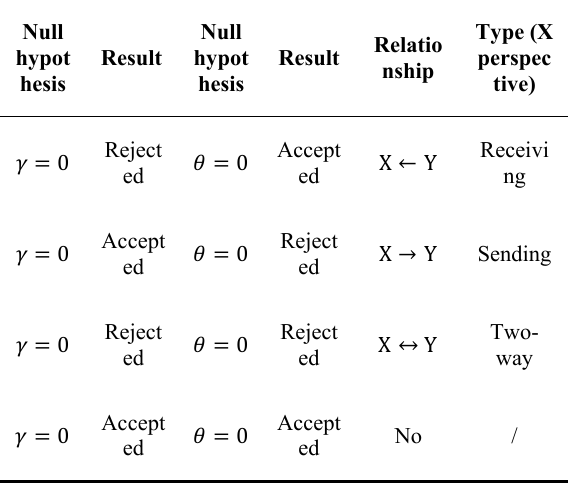
Table 2. Criteria used for Granger causality test when the forward time window = 1 (Zhang et al.,